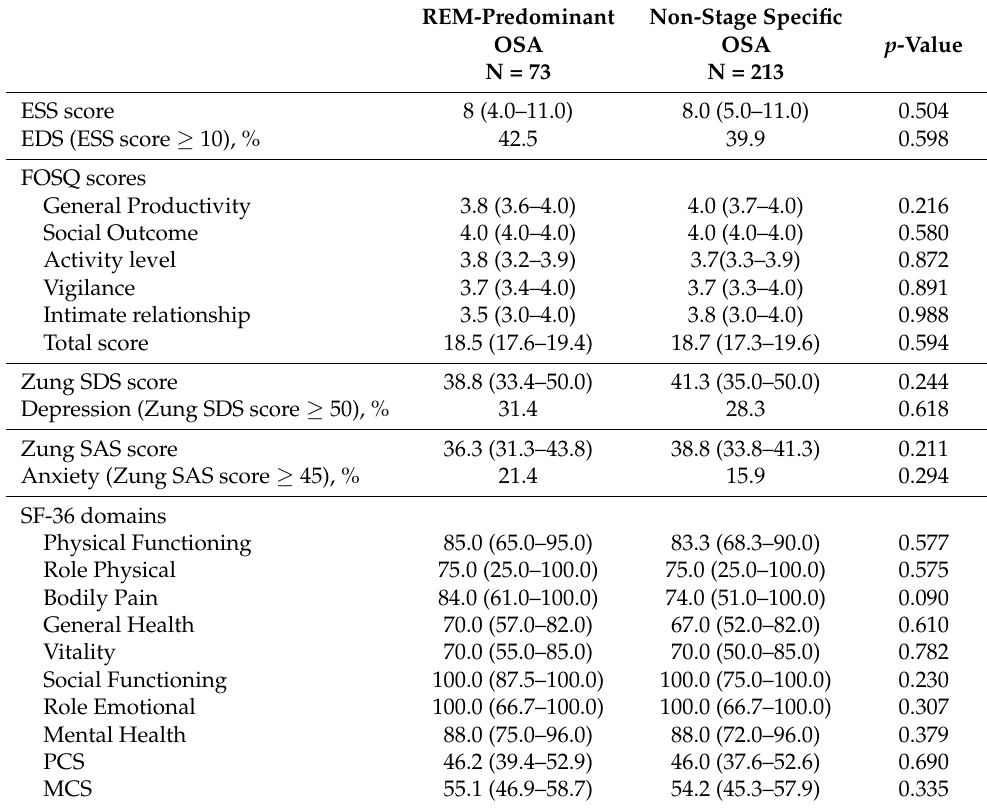
Table 3. Comparison of excessive sleepiness, functional outcomes, depression, anxiety, and qual- ity of life measures of the study participants ( n = 286) polysomnographic findings of the study population ( n =